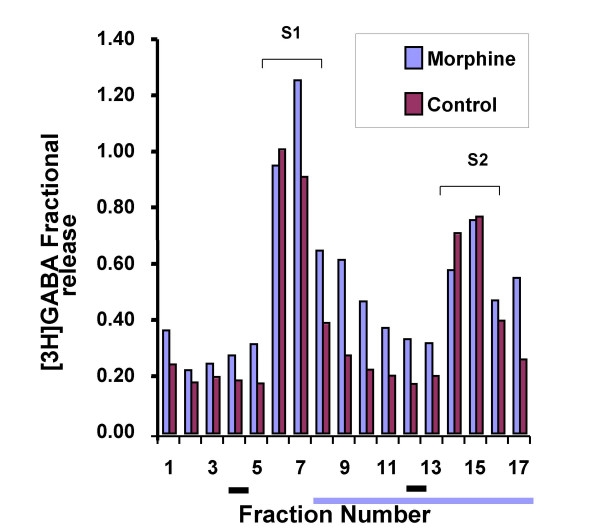
Elution profile of KCl-stimulated [3H]GABA release from inferior colliculus slices. Inferior colliculus slices were incubated with 11 nM [3H]GABA for 30 min and perfused (0.5 ml/min) with Krebs buffer for 30 min in a Brandel superfiltration apparatus. Fractions (1 ml) were then collected every 2 min. Krebs buffer containing 25 mM KCl was loaded into the system at times corresponding to fraction 4 and 12 (short black lines) which elicited [3H]GABA release peaks in fractions 6–7 and fraction 14–15. Krebs buffer containing modulating drugs (1 μM morphine-long blue line) was added from the time corresponding to fraction 8. Scintillation fluid (3 ml) was added to the each fractionated eluate and to the solubilized tissue samples and counted. Data are expressed as fractional release which is calculated as the radioactivity released in one fraction divided by the amount of radioactivity present in the tissue just before that fraction. The two peaks from each elution profile are referred to as S1 and S2. The data from a representative experiment are shown.